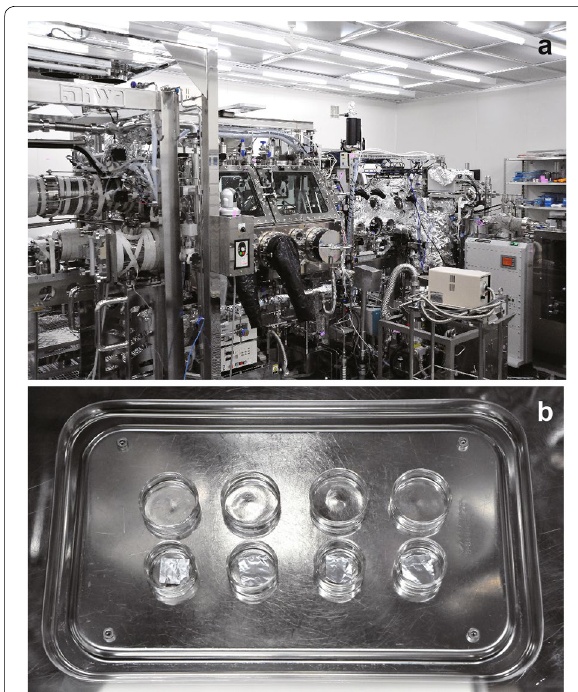
Fig. 1 a The clean chamber in the curation room at ISAS/JAXA and b the witness coupons placed in the